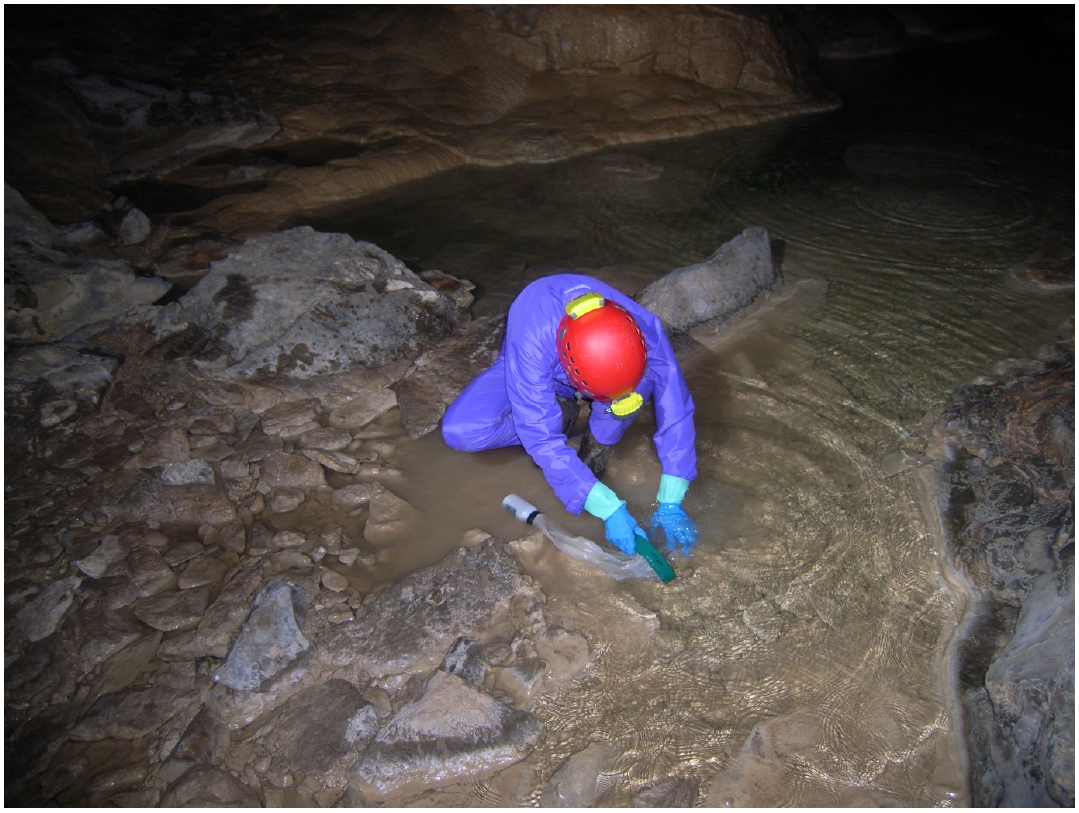
Figure 5. Sampling in “Sala Edelweiss” OG09. Photo C. Puch.